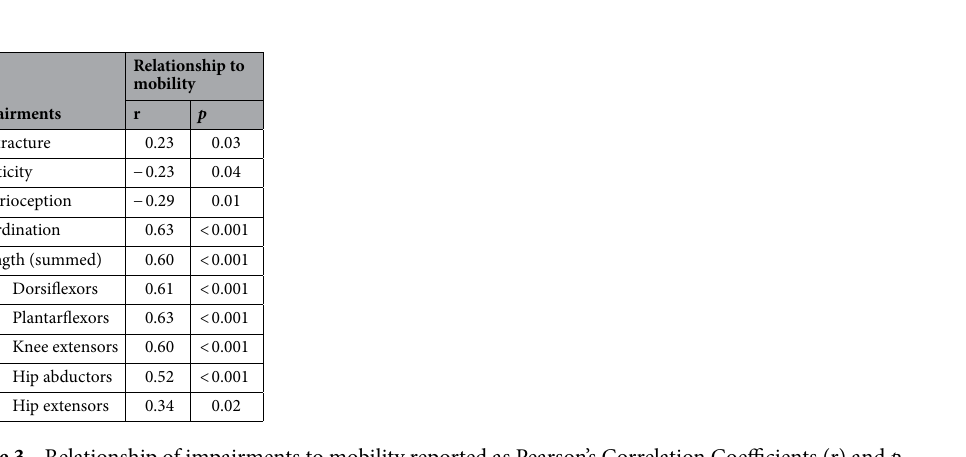
Table 3. Relationship of impairments to mobility reported as Pearson’s Correlation Coefficients (r) and p